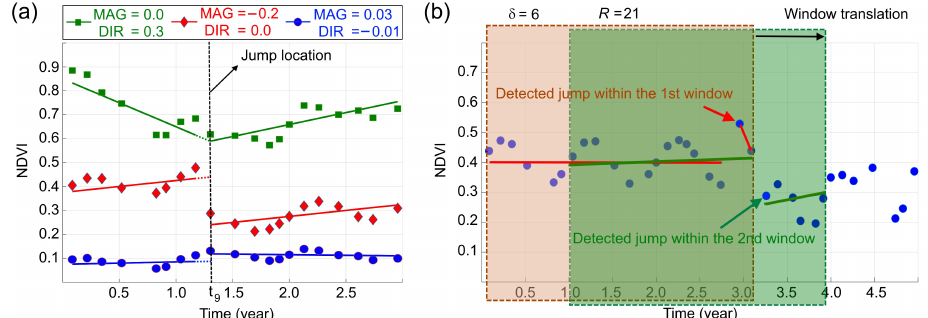
Figure 3. ( a ) an illustration of jumps in the trend component of three different NDVI time series. DIR and MAG denote the true direction and magnitude of the jump located at t 9 , respectively, and ( b ) the translating window of size R = 21 observations, translating (sliding) by δ = 6 observations. JUST has detected a jump within the first window (see the red arrow) and another jump within the second window (see the green arrow). The solid red and green lines are the estimated linear trends (each trend has two pieces) corresponding to the segments within the red and green windows,